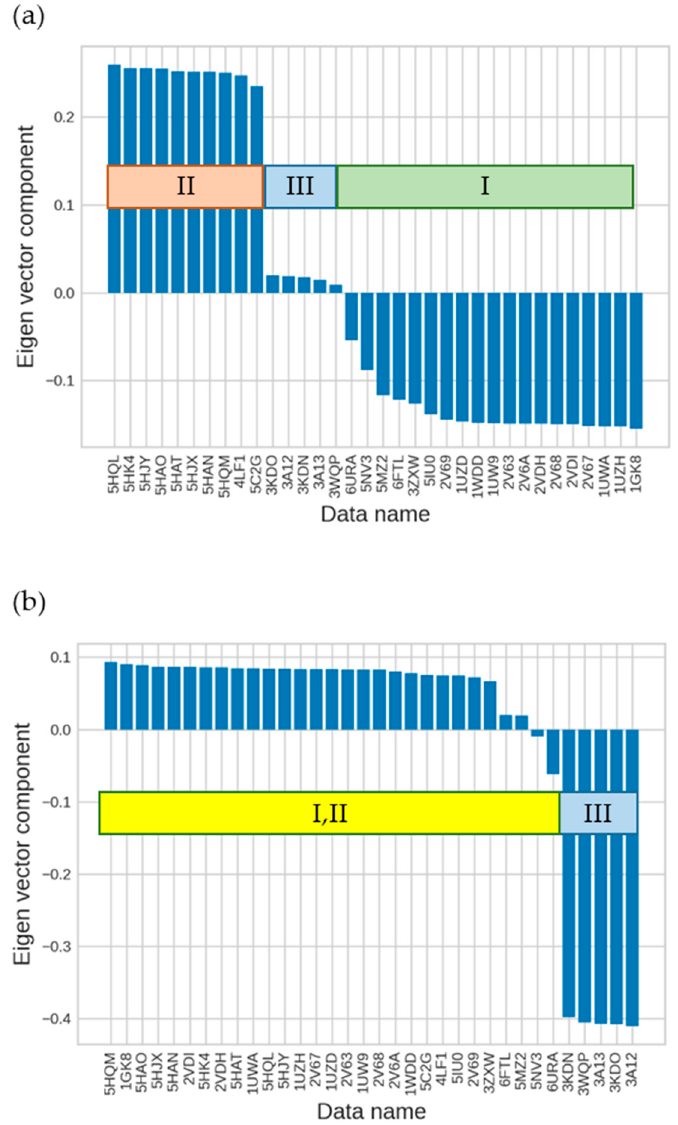
Figure 12. SVD analysis of structures using normalized IFIE data (left-singular vectors). ( a ) The first and ( b ) second left-singular vectors for each structure. Table 4. Top eight sites with the largest absolute values of eigenvector elements in the first and second left-singular vectors of SVD.